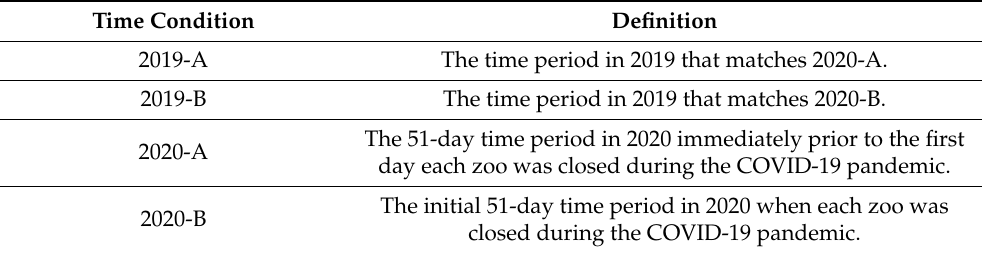
Table 2. The Four Time Conditions and their